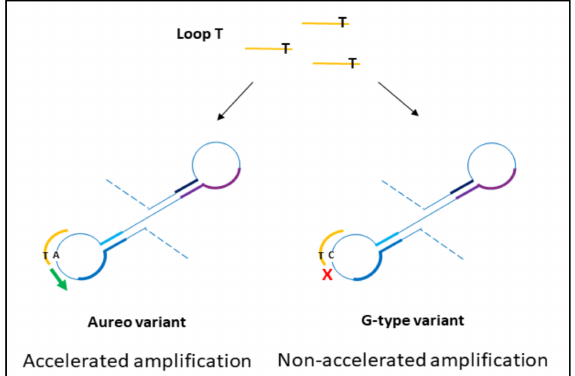
Figure 1. Schematic representation of the hybridization of loop primers to amplicon loops from durum wheat variants. During the exponential phase of loop-mediated isothermal amplification (LAMP) reaction, the perfect match between loop T and the complementary region on the Aureo intermediate loops accelerates the amplification, while the presence of the single mismatch between loop T and G-variant amplicon loops causes the short primer destabilization and a significant reaction delay. The results are reversed for loop G mediated